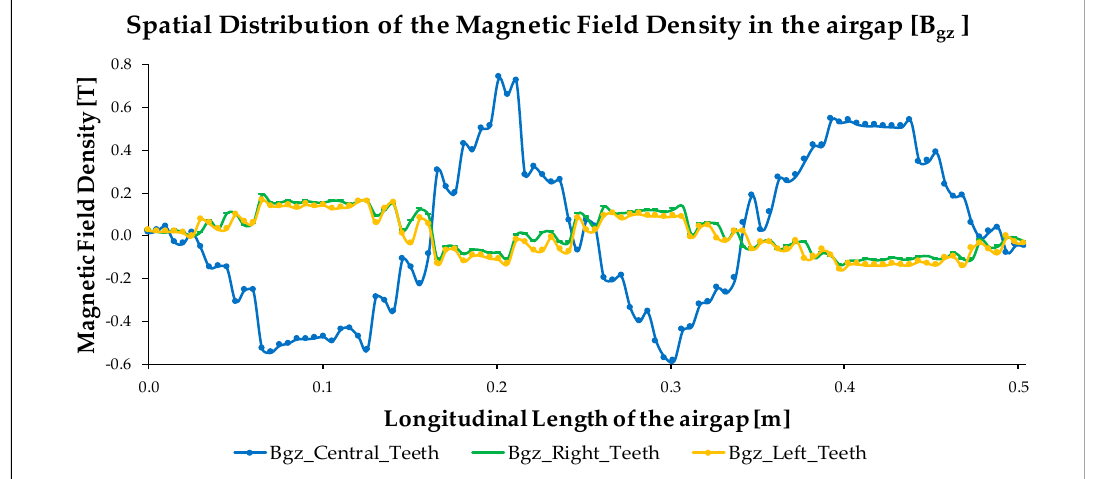
Figure 9. Distribution of the magnetic field density along the airgap.